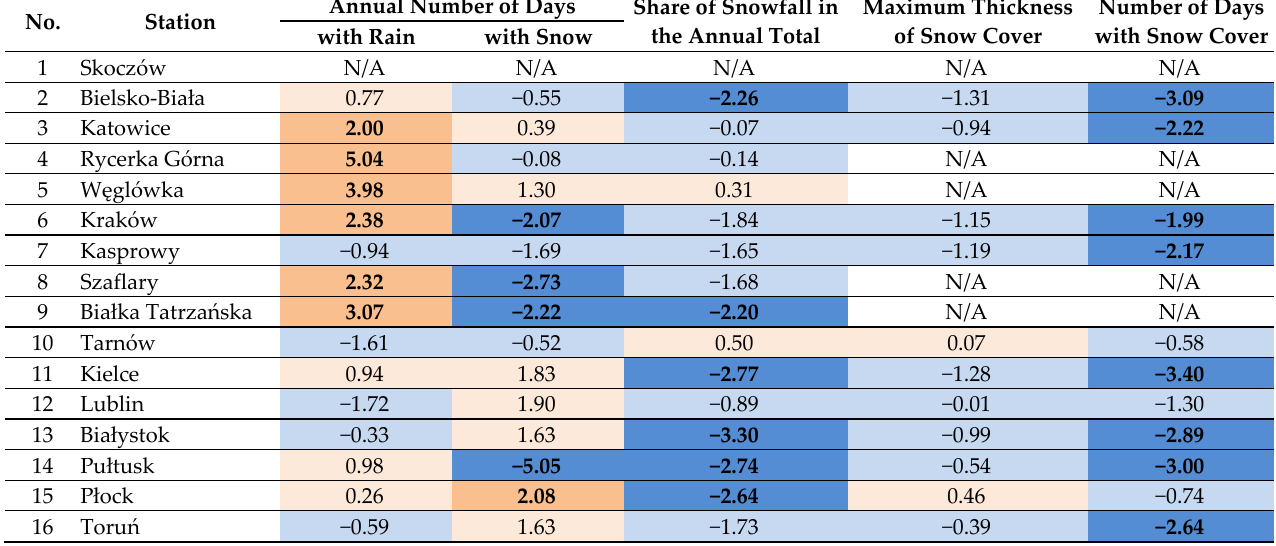
Table 10. Results of the Mann test ( uF statistics) for trends in annual precipitation characteristics; orange colour denotes positive uF values, blue colour negative. Numbers in bold indicate statistically significant changes at α level 0.05. No. Annual Number of Days Share of Snowfall in Maximum Thickness Number of Days No. Station the Annual Total of Snow Cover with Snow Cover with Rain with